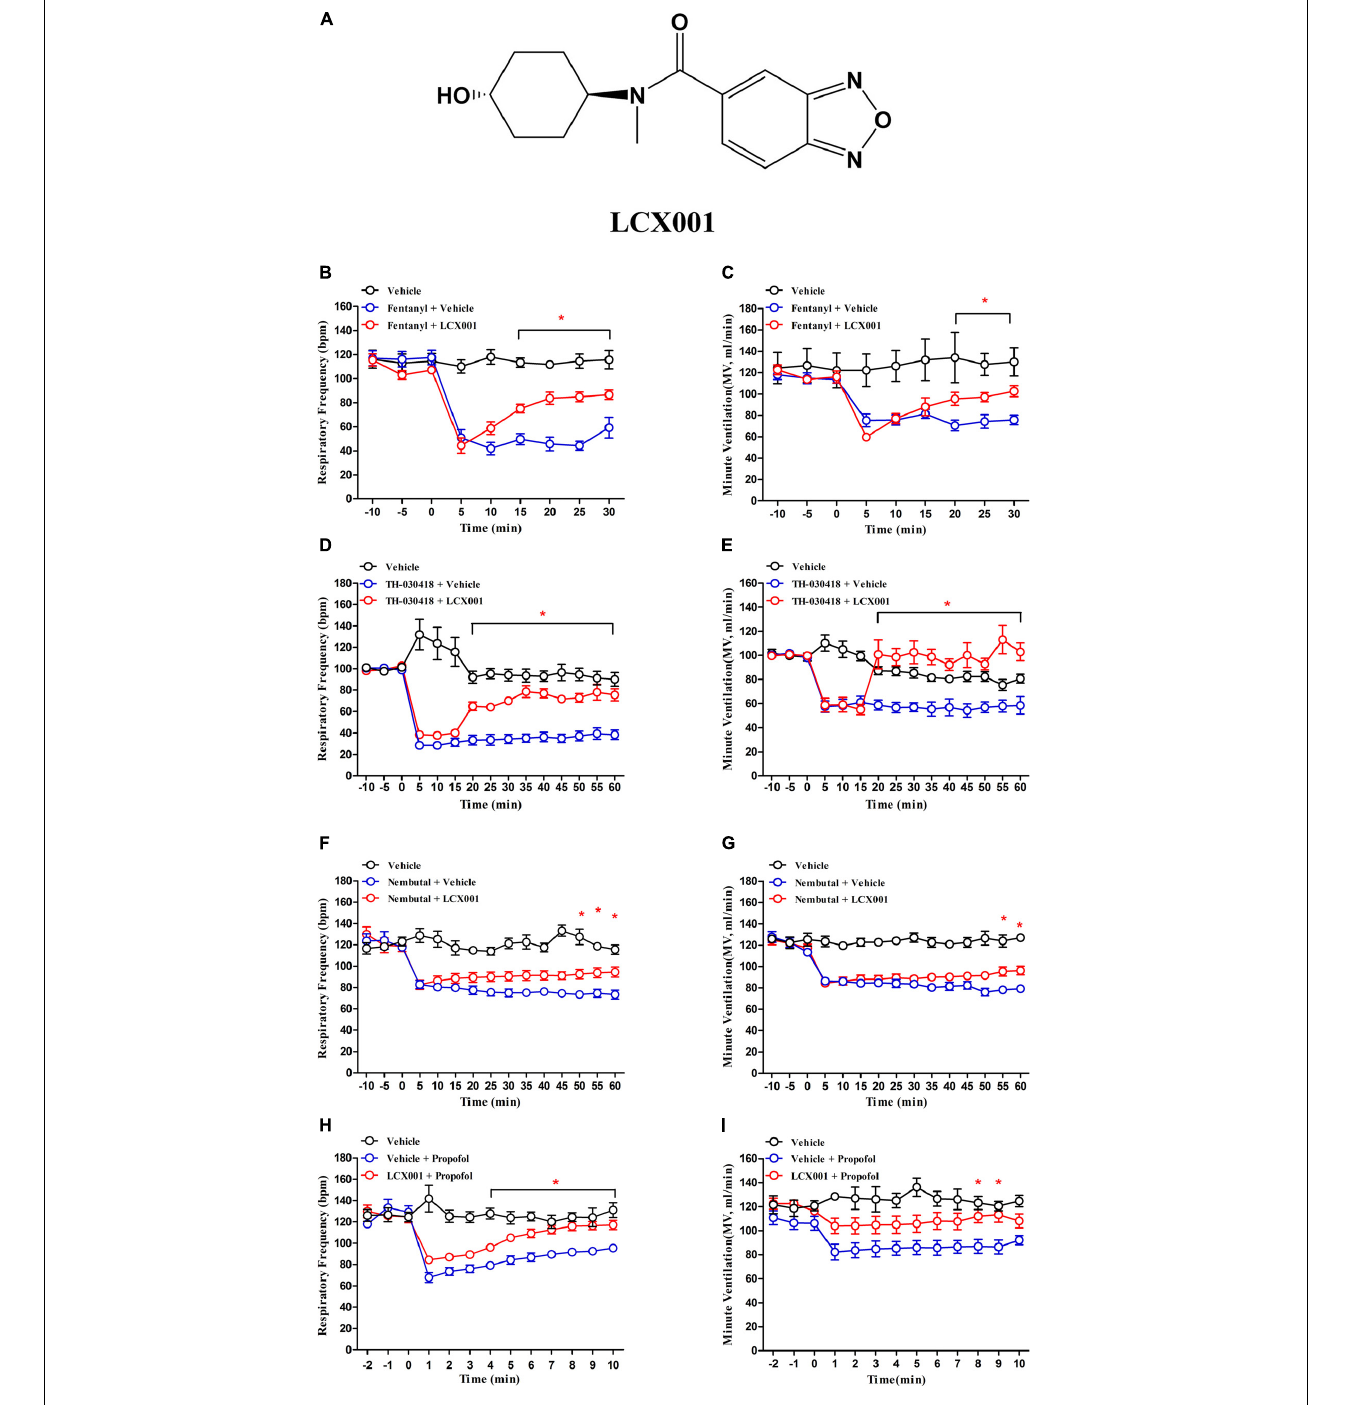
FIGURE 1 | Administration of LCX001 (10 mg/kg, i.v.) protected against opioid, propofol and pentobarbital (Nembutal) induced respiratory depression in unanaesthetised adult rats. The data, acquired from whole body plethysmography, showed the time-varying changes of respiratory frequency (bpm) and minute ventilation (MV) in response to opioid, propofol and pentobarbital administration after post- or pre-treatment of vehicle (20% HPCD) or LCX001 . (A) Chemical structure of the modulator, LCX001 (N-((1r,4r)-4-hydroxycyclohexyl)-N-methylbenzo[c][1,2,5]oxadiazole-5-carboxamid. (B,C) 5 min after fentanyl (120 µ g/kg, s.c.), injection of LCX001 (10 mg/kg, i.v.) effectively countered the inhibition of respiratory frequency and minute ventilation. (D,E) LCX001 (10 mg/kg, i.v.) administered 5 min after TH-030418 (20 µ g/kg, i.v.) alleviated the reduction of respiratory parameters. (F,G) 5 min after Nembutal (80 mg/kg, i.p.) administration, LCX001 (10 mg/kg, i.v.) ameliorated respiratory depression by increasing respiratory rate and minute ventilation. (H,I) LCX001 (10 mg/kg, i.v.) administered 10 min before propofol (30 mg/kg, i.v.) reversed the acute reduction of respiratory frequency and minute ventilation. ∗ Significant difference from fentanyl, TH-030418, Nembutal and propofol groups by two-way ANOVA, Bonferroni post-hoc tests; LCX001 ( ∗ P < 0.05) relative to the fentanyl, TH-030418, Nembutal and propofol groups; mean ± SEM, each symbol represented data from six male SD rats. Frontiers in Pharmacology |